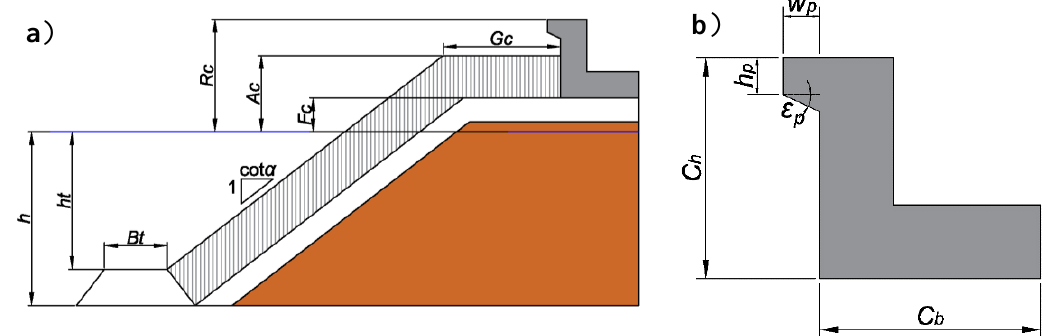
Figure 1. Cross-section of ( a ) a conventional mound breakwater with a toe berm and crown wall and ( b ) parapet characteristics.